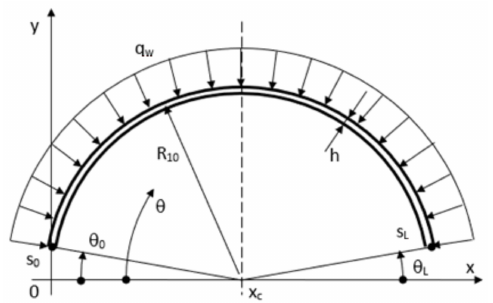
Figure 5. Single-layer spherical shell under the action of a static uniformly distributed external load of the “tracking”